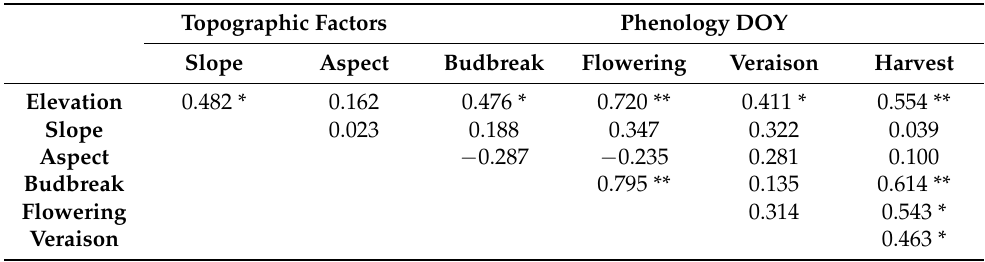
Table 4. Pearson’s correlation matrix for the topographic factors, phenology event days.